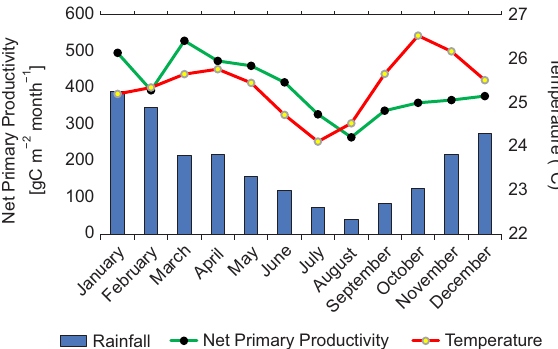
Fig. 9. Temporal variation of net primary productivity (NPP) and climate condition in Surakarta City.